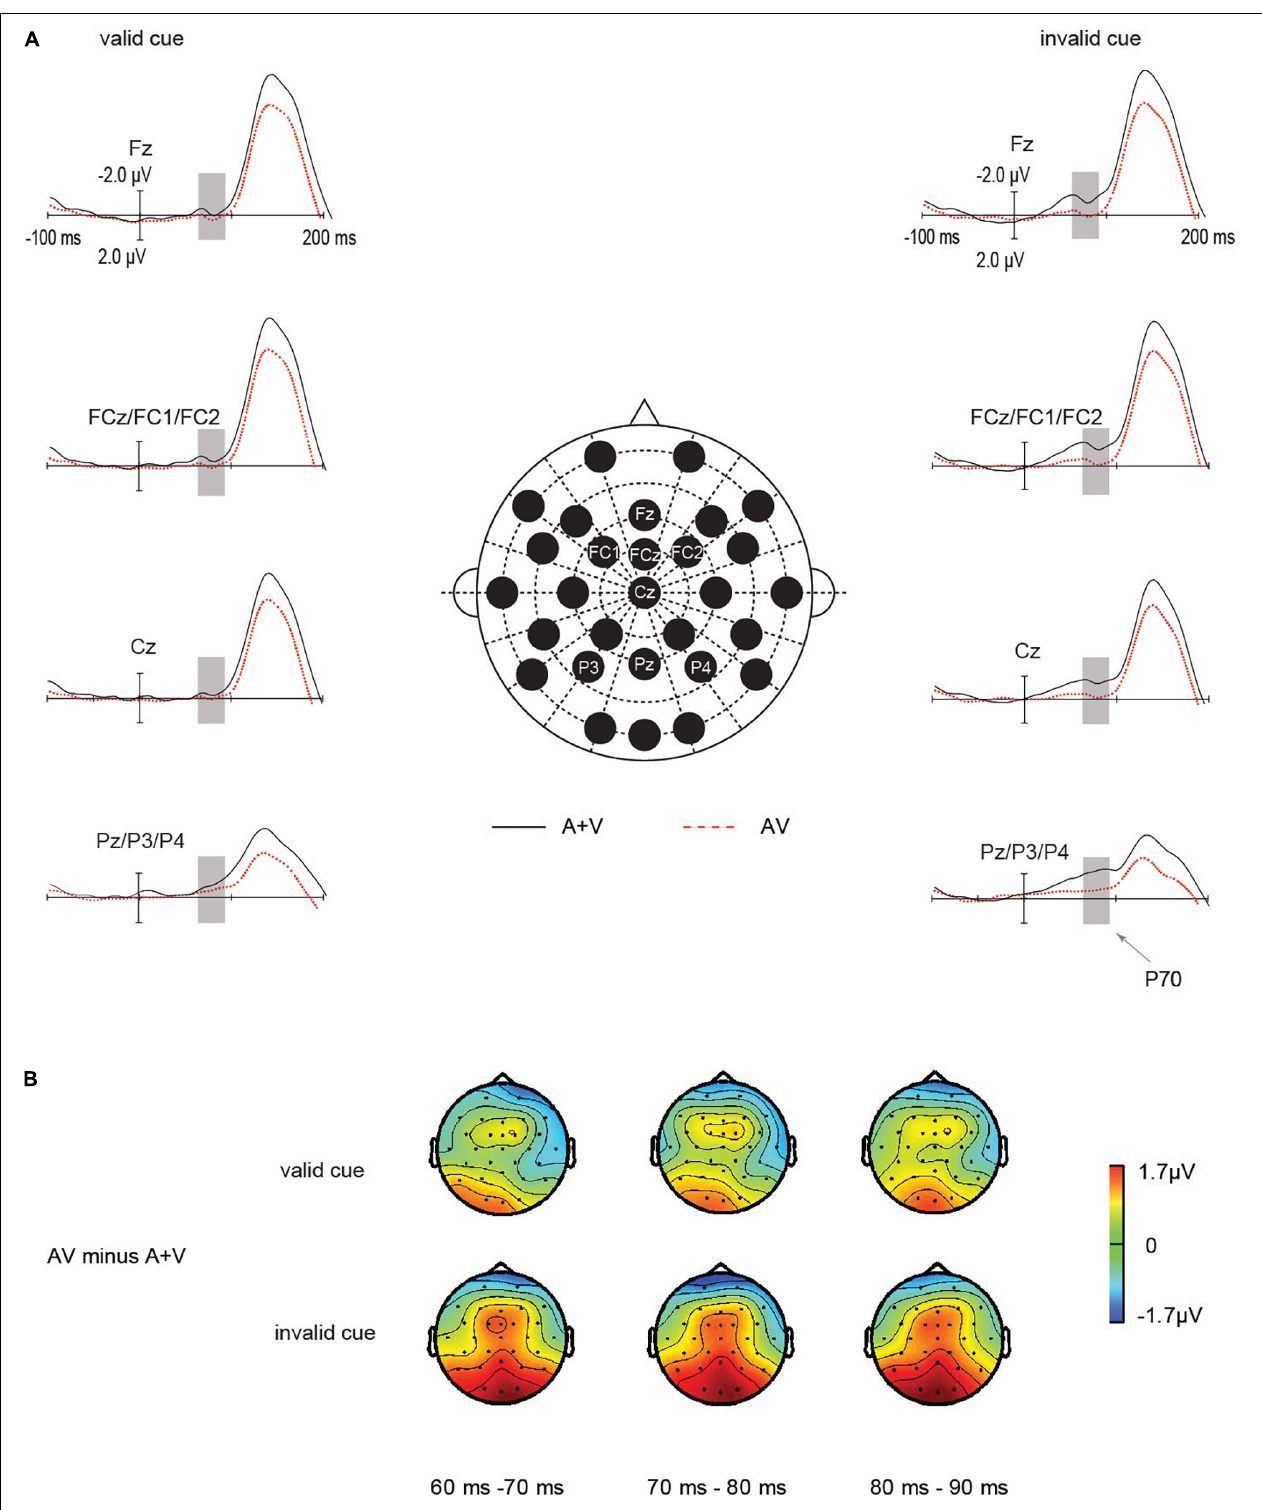
FIGURE 3 | Audiovisual integration by IOR interactions on the fronto-central P70 components. The P70 components for the audiovisual stimuli were noticeably greater under the invalid cue condition as compared with that for the total unisensory response, whereas this study did not find such an effect in the valid cue. (A) Grand average ERPs of differences between AV (red dotted line) and A + V (black solid line) conditions. (B) The scalp topographies of the P70 components of AV minus A + V condition.